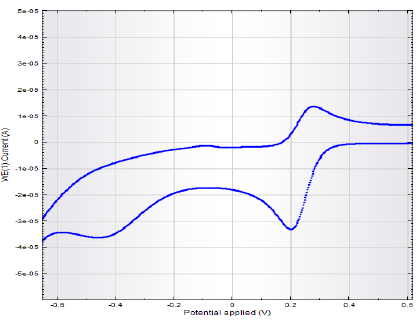
Figure A9. CV registered on graphite-based SPE in the presence of 2 mM TEMPO in 0.1 M HClO 4 . Differential pulse voltammetry (DPV) was then applied in order to evaluate the antioxidant effectiveness of the novel compounds through their ability to scavenge the free radical species. Figure A10-left shows the DPVs of 2 mM TEMPO and of 2 mM TEMPO incubated for one hour with different concentrations of ascorbic acid. It can be observed that the anodic peak of TEMPO decreases when increasing the concentration of ascorbic acid, used as control antioxidant.